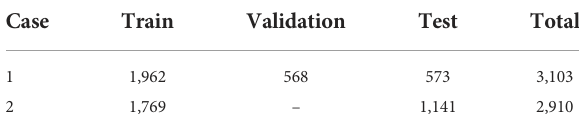
TABLE 1 Descriptions of two cases in MAS3K datasets for training, validation, and testing. TABLE 2 Hyperparameters used for training of PSS-Net.